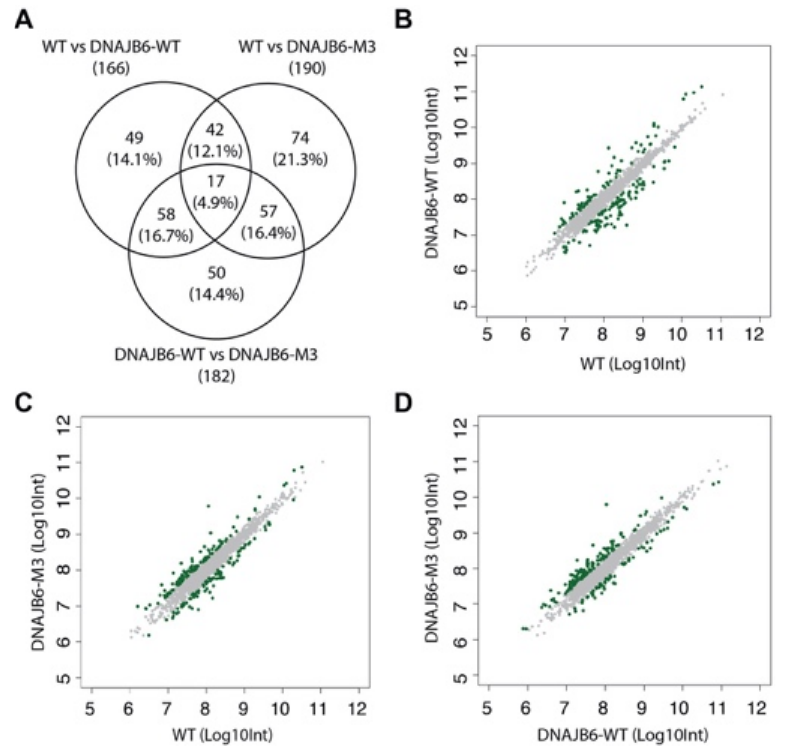
Figure 5. Identification of differentially expressed proteins among WT, DNAJB6-WT, and DNAJB6- M3 EVs. ( A ) Venn diagram of differentially expressed proteins in WT, DNAJB6-WT, and DNAJB6-M3 EVs. Scatter plot depicting differential intensity values for proteins found in ( B ) WT and DNAJB6-WT, ( C ) WT and DNAJB6-M3, and ( D ) DNAJB6-WT and DNAJB6-M3. Green dots represent proteins with differential expression of FC > 2, i.e., >|Antilog (0.3)|. Int: intensity